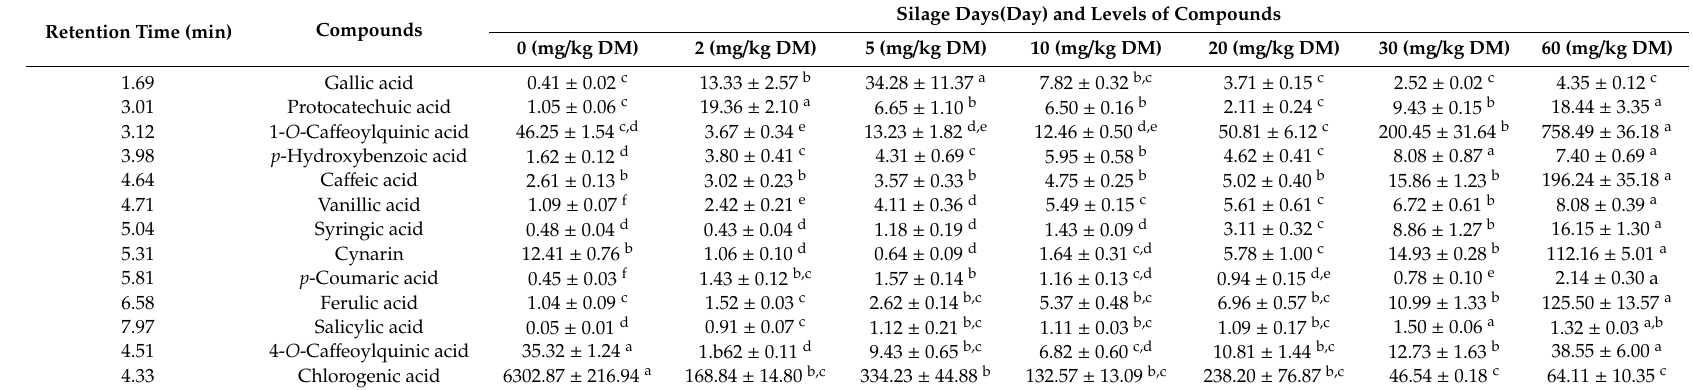
Table 1. E ff ects of silage on phenolic acid composition in artichoke by-products.